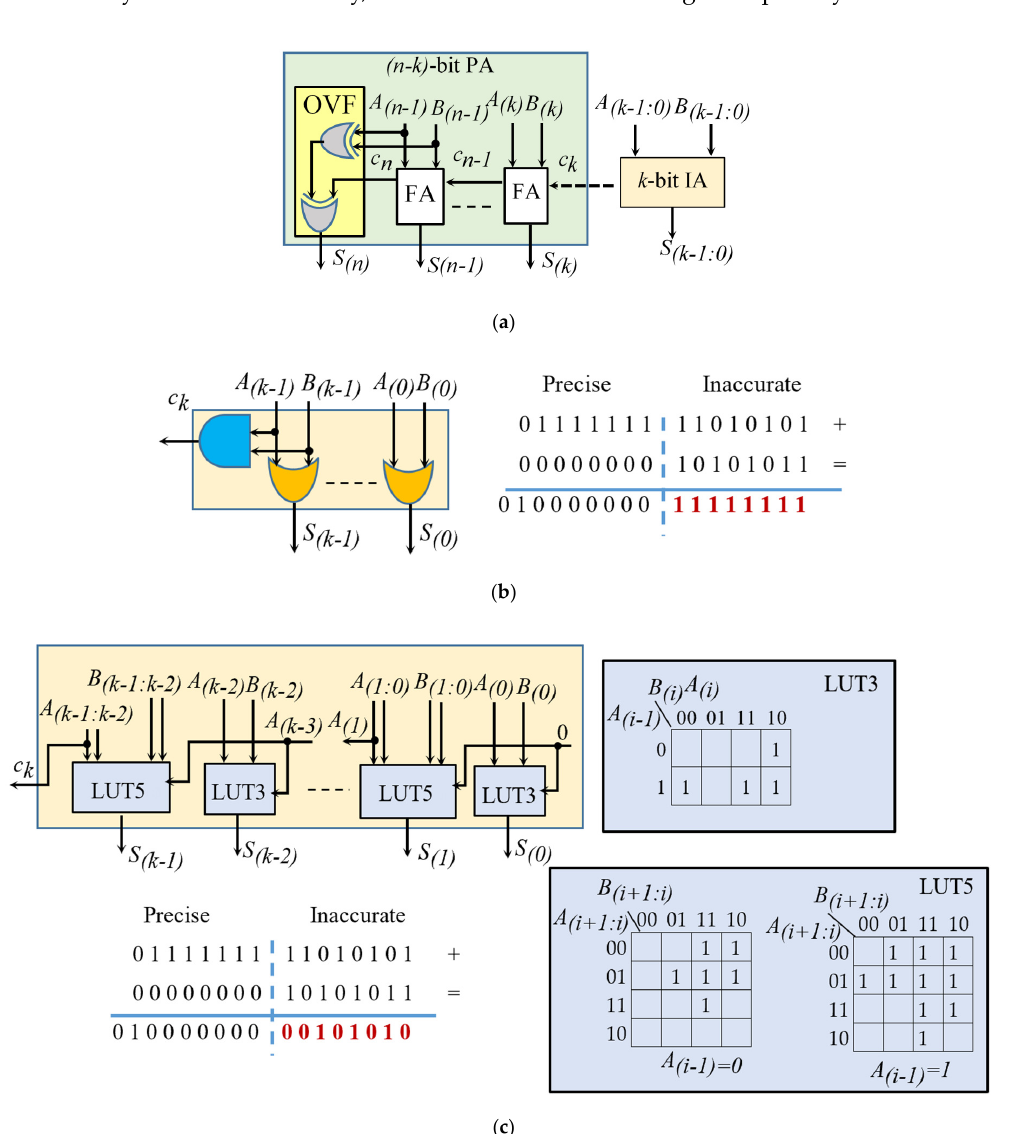
Figure 1. Existing approximate adders: ( a ) the top-level architecture; ( b ) Lower-part OR Adder (LOA) [13]; ( c ) AA6 [16].